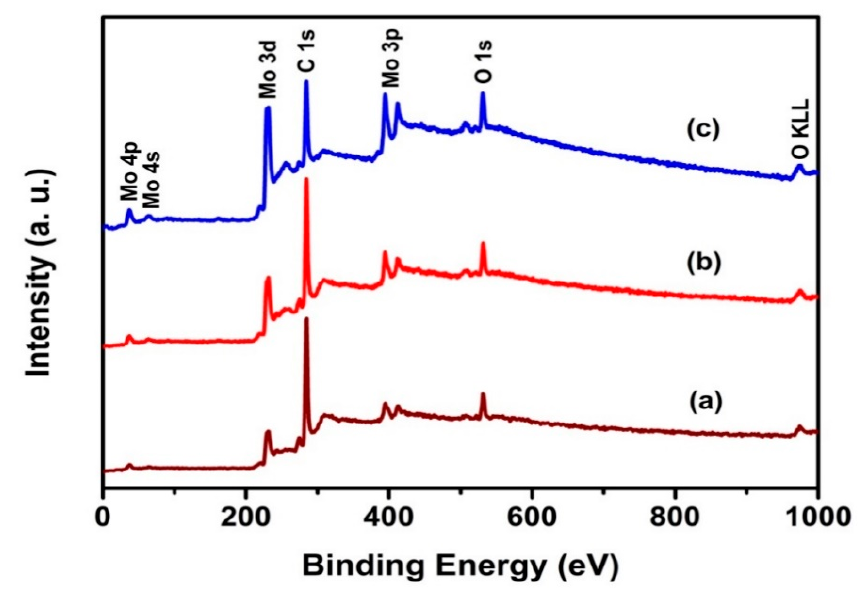
Figure 2. Survey spectra of Mo-DLC coatings: ( a ) 3.9 at.% Mo, ( b ) 6.9 at.% Mo, and ( c ) 16.2 at.% Mo.